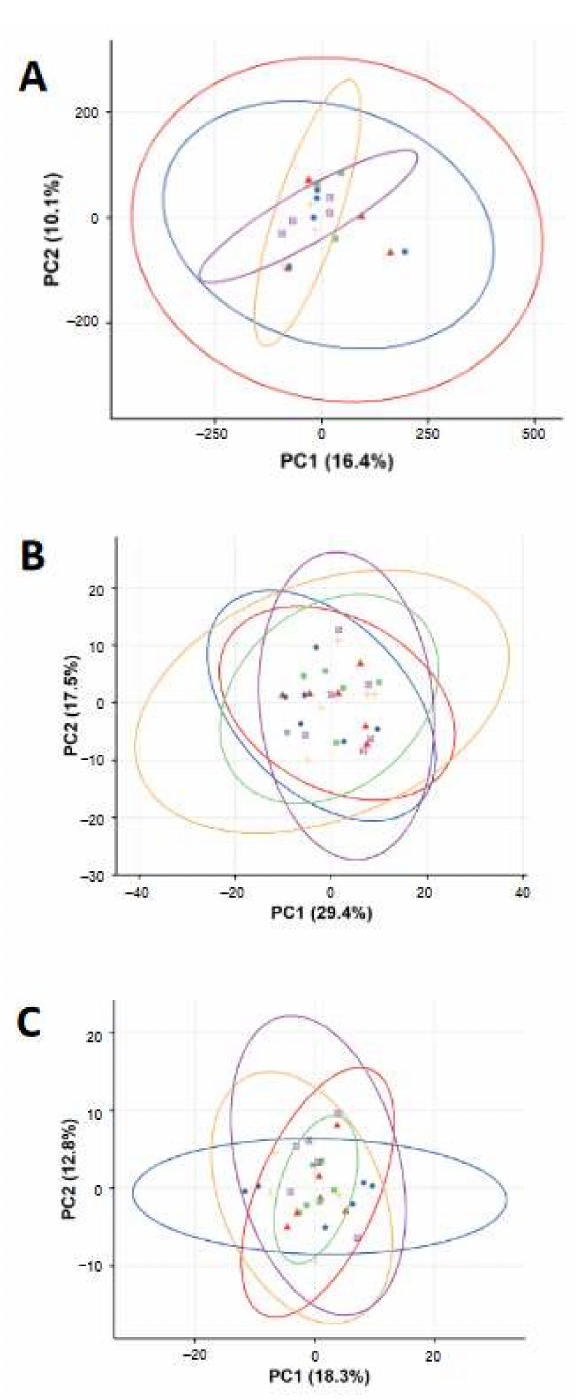
Figure 3. Principal component analysis (PCA) score plots of the gene expression ( A ) and metabolomics profiles (( B ) in positive ion mode and ( C ) in negative ion mode) of BEAS-2B cells treated with H 2 O and FeO x NPs. Symbols in the PCA plots indicate individual repeats of BEA-2B cells of control group (circle ) or exposed to Fe 3 O 4 B (triangle ), FeO x -mix A (square ), FeO x -mix B (plus ), and FeO x -mix C (plus ). 2.2. Nose-only Inhalation Study of FeO x NPs in Sprague Dawley Rats